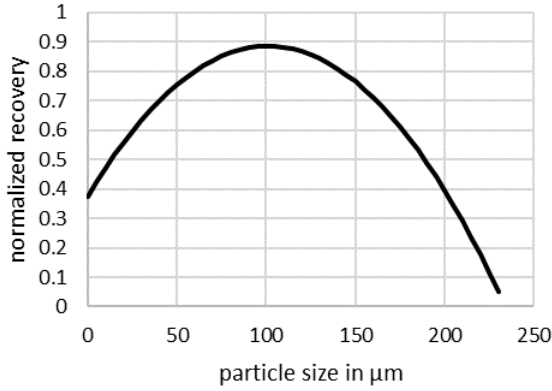
Figure 9. Characteristic line for sphalerite particle recovery derived from experimental results.